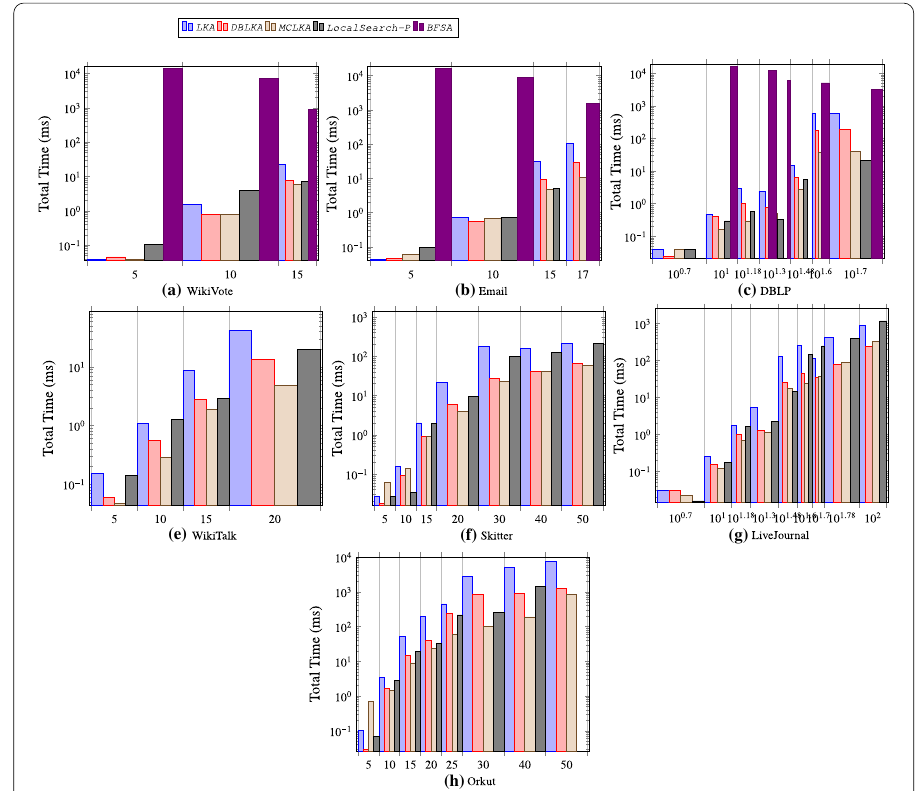
Fig. 8 Execution time of the proposed algorithms against BFS and LocalSearch‑P Algorithms while r and k is